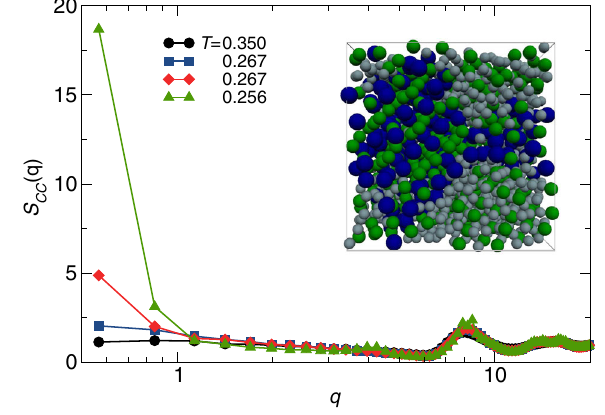
ð q Þ for small particles in the FIG. 7. Partial structure factor S CC ternary mixture of Sec. III B. It is featureless at high enough temperatures, T ¼ 0 . 350 , and displays strong composition fluc- tuations at low k in the fluid at T ¼ 0 . 267 , which may eventually lead to a demixed state at long times. For T ≤ 0 . 26 , the system is demixed, as shown for T ¼ 0 . 256 . The inset shows a represen- tative snapshot of a demixed and partially crystallized system at T ¼ 0 . 256